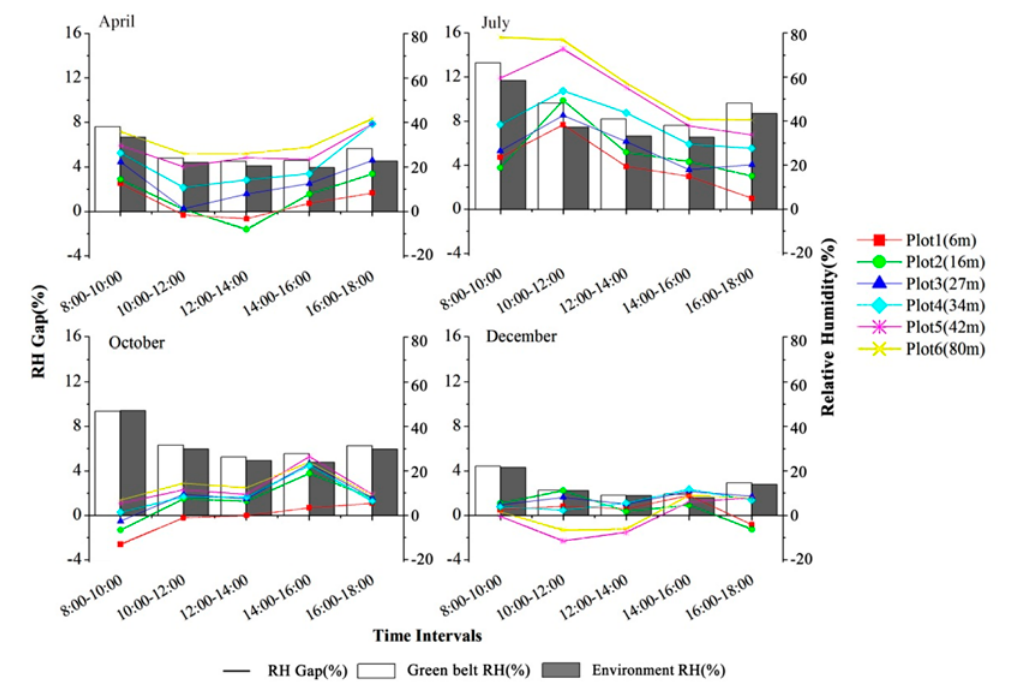
Fig. 4. RH changes of green belts over five time